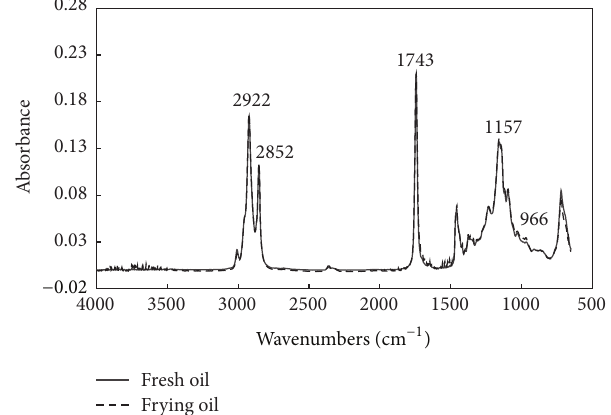
Figure 2: FTIR spectra of the fresh and used canola